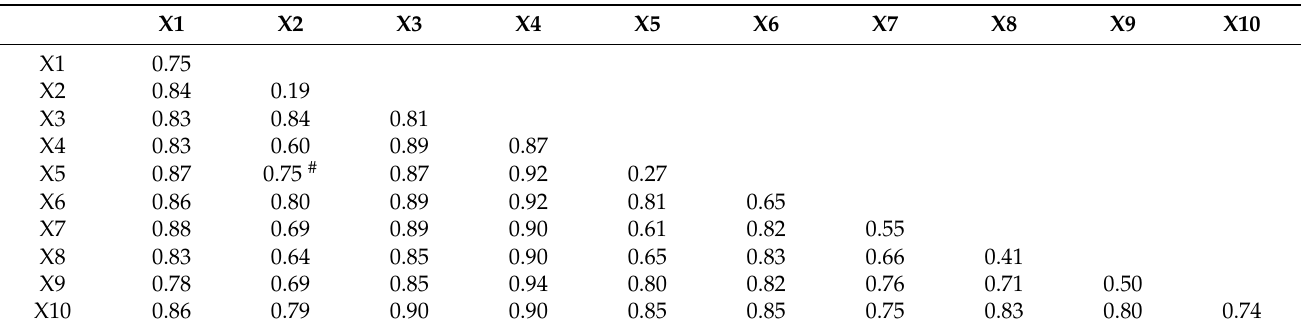
Table 6. Interaction detection results of driving factors of ESV.